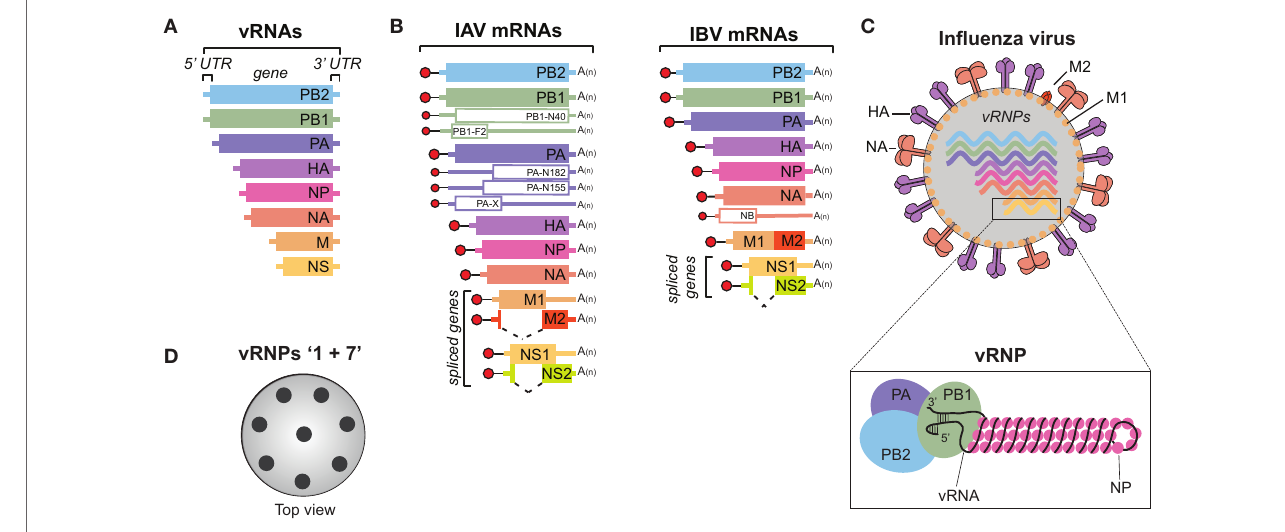
FigURe 1 | Influenza A and B viruses. (A) Schematic of the eight viral RNA (vRNA) gene segments that comprise the influenza A and B genomes. The 5 ′ and 3 ′ untranslated regions (UTRs), which contain the viral promoters, are represented with a line, and the box corresponds to the coding region within each vRNA. (B) Diagram of the viral mRNAs that are transcribed from the IAV (left) and IBV (right) vRNA templates. Boxes indicate the viral gene product encoded by each mRNA and the dashed lines show the alternative splicing of the IAV M and NS transcripts, as well as the IBV NS transcript. Red circles represent the 5 ′ M 7 pppG cap, black lines denote the 10–13 nucleotide, host-derived primers that are obtained by the cap-snatching mechanism of the viral polymerase. A(n) corresponds to the 3 ′ poly-A tail produced by reiterative stuttering of the viral polymerase. The smaller mRNAs (empty boxes) represent transcripts that encode nonessential accessory proteins found in many strains, whereas those that are less prevalent (PB2-S1, M42, and NS3) are not illustrated (6–11). (C) Diagram of an influenza A or B virus. The viral membrane proteins HA, NA, and M2 are shown, along with the eight viral ribonucleoproteins (vRNPs), and the matrix protein M1 that supports the viral envelope. To highlight the vRNP components, the illustration beneath the virus is not to scale. A single vRNA gene segment is shown wrapped around multiple nucleoprotein (NP) copies with the conserved promoter regions in the 5 ′ and 3 ′ UTRs forming a helical hairpin, which is bound by a single heterotrimeric viral RNA-dependent RNA polymerase (PB1, PB2, and PA). (D) Top view of an influenza virus cross-section showing the vRNP “1 + 7” configuration. vRNPs are depicted with black circles as it is not known if the positioning of a particular vRNP is conserved or